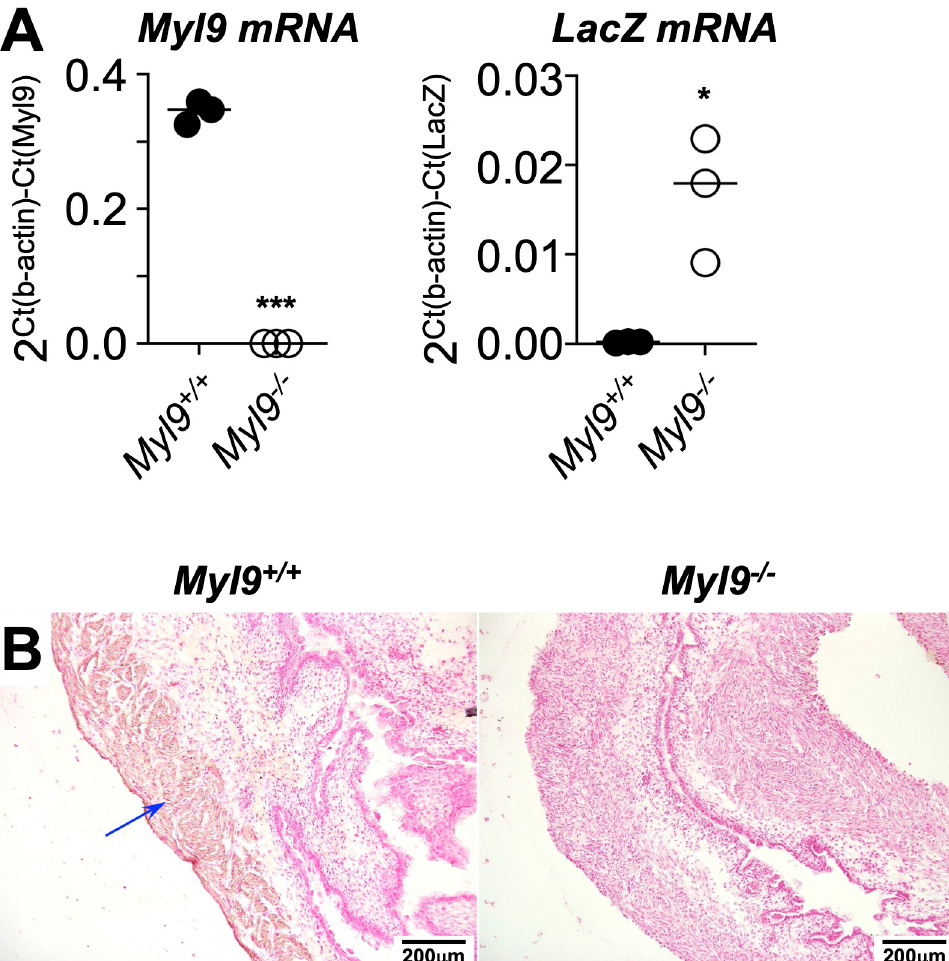
Fig 3. Confirmation that the Myl9 knockin/out allele ablates MYL9 expression. (A) RNA from the bladder of Myl9 +/+ and Myl9 -/- pups at D0 post-partum were analyzed for the expression of Myl9 (wildtype) or LacZ mRNA. Each circle is an individual animal, with means indicated by the lines. Comparisons were assessed by t-test ( � P < 0.05, ��� P < 0.0005). The individual data points are provided in S2 File. (B) Sections of the bladder of a representative pair of pups were stained with an anti-MYL9/12A/12B antibody (brown stain) and counterstained with nuclear fast red. The blue arrow indicates staining in the muscularis propria of the Myl9 +/+ bladder.